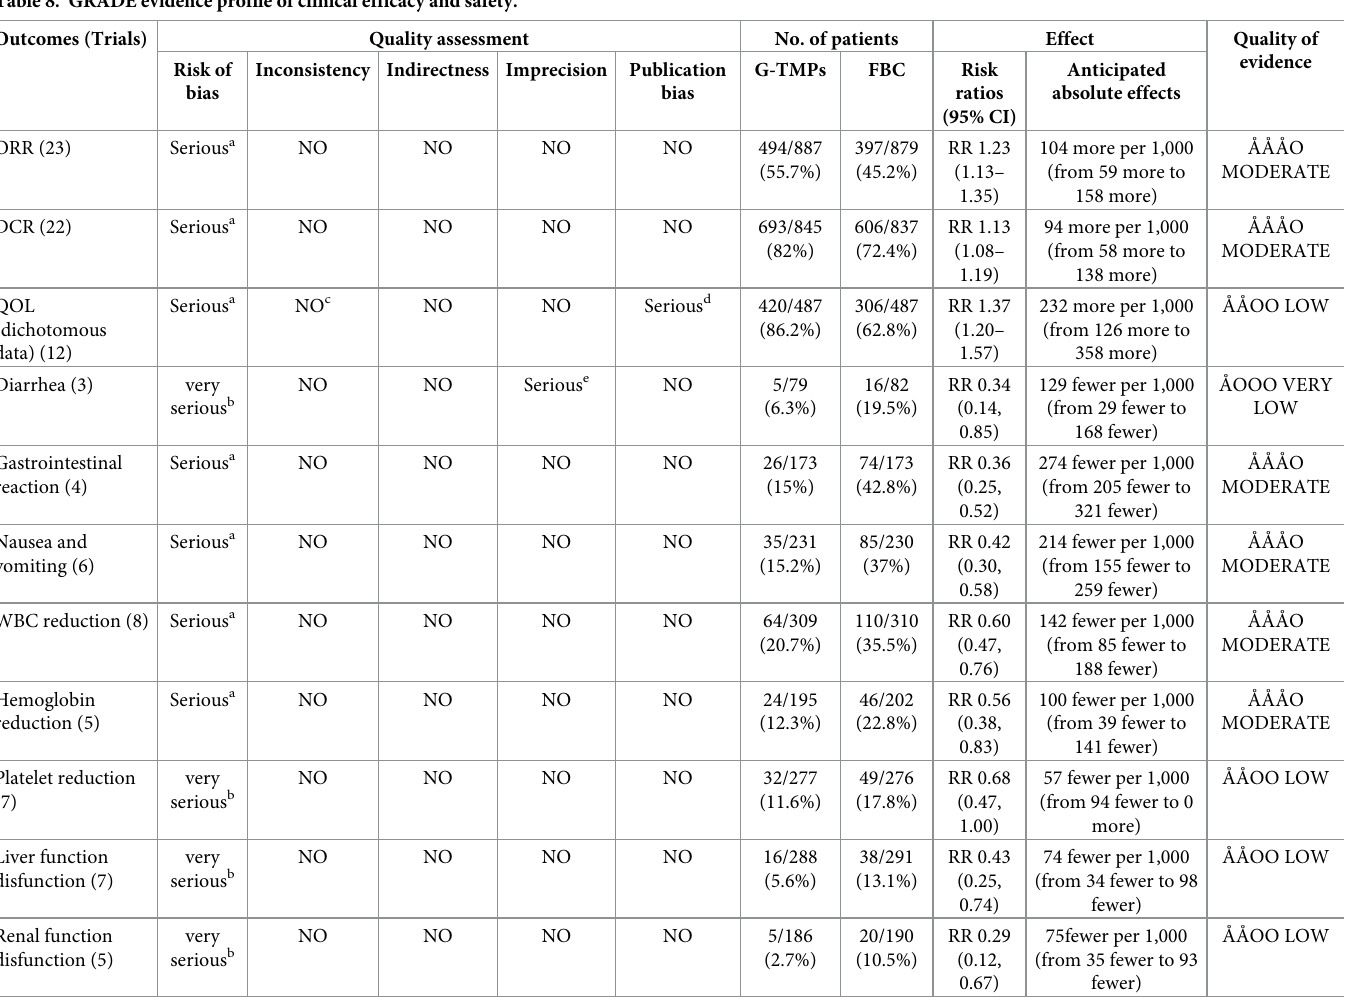
Table 8. GRADE evidence profile of clinical efficacy and